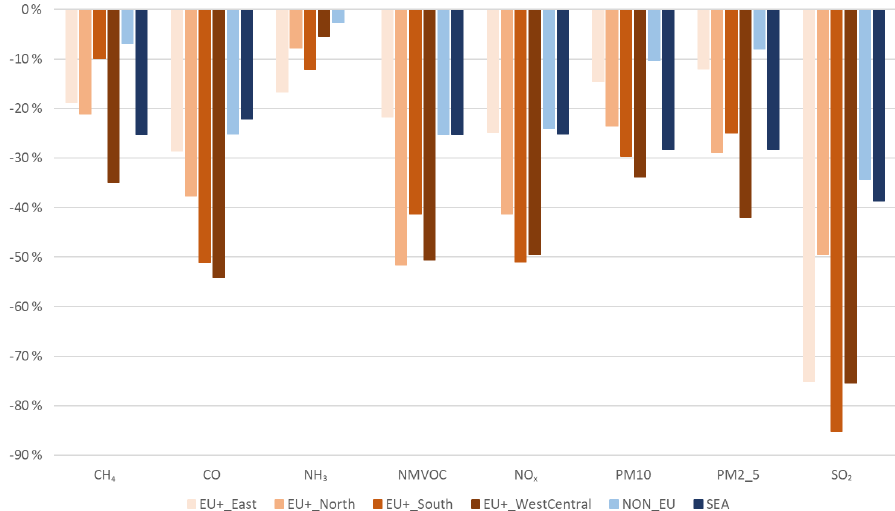
Figure 3. Emission change between 2000 and 2017 per pollutant and per country